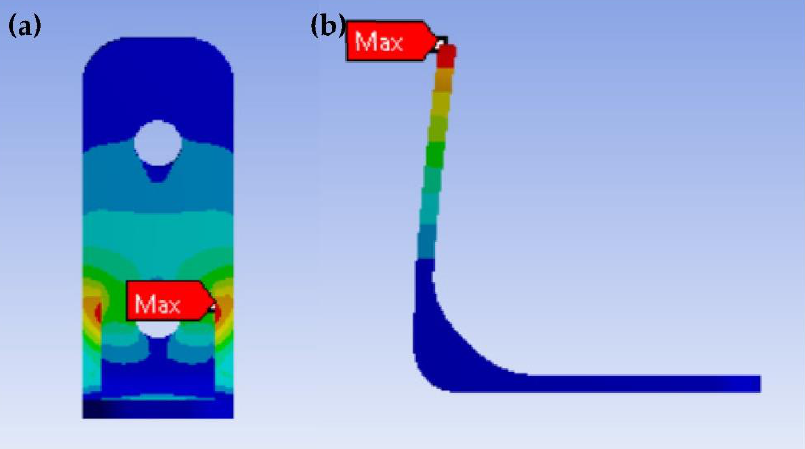
Figure 6. Simulation results of Mode-2 showing ( a ) maximum stress and ( b ) maximum deformation.